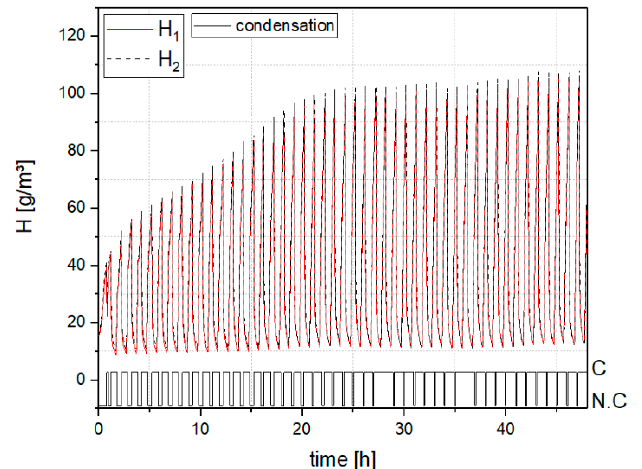
Figure 11. Absolute humidity of the air and condensation inside the housing during abnormal operation in case of the open battery system.